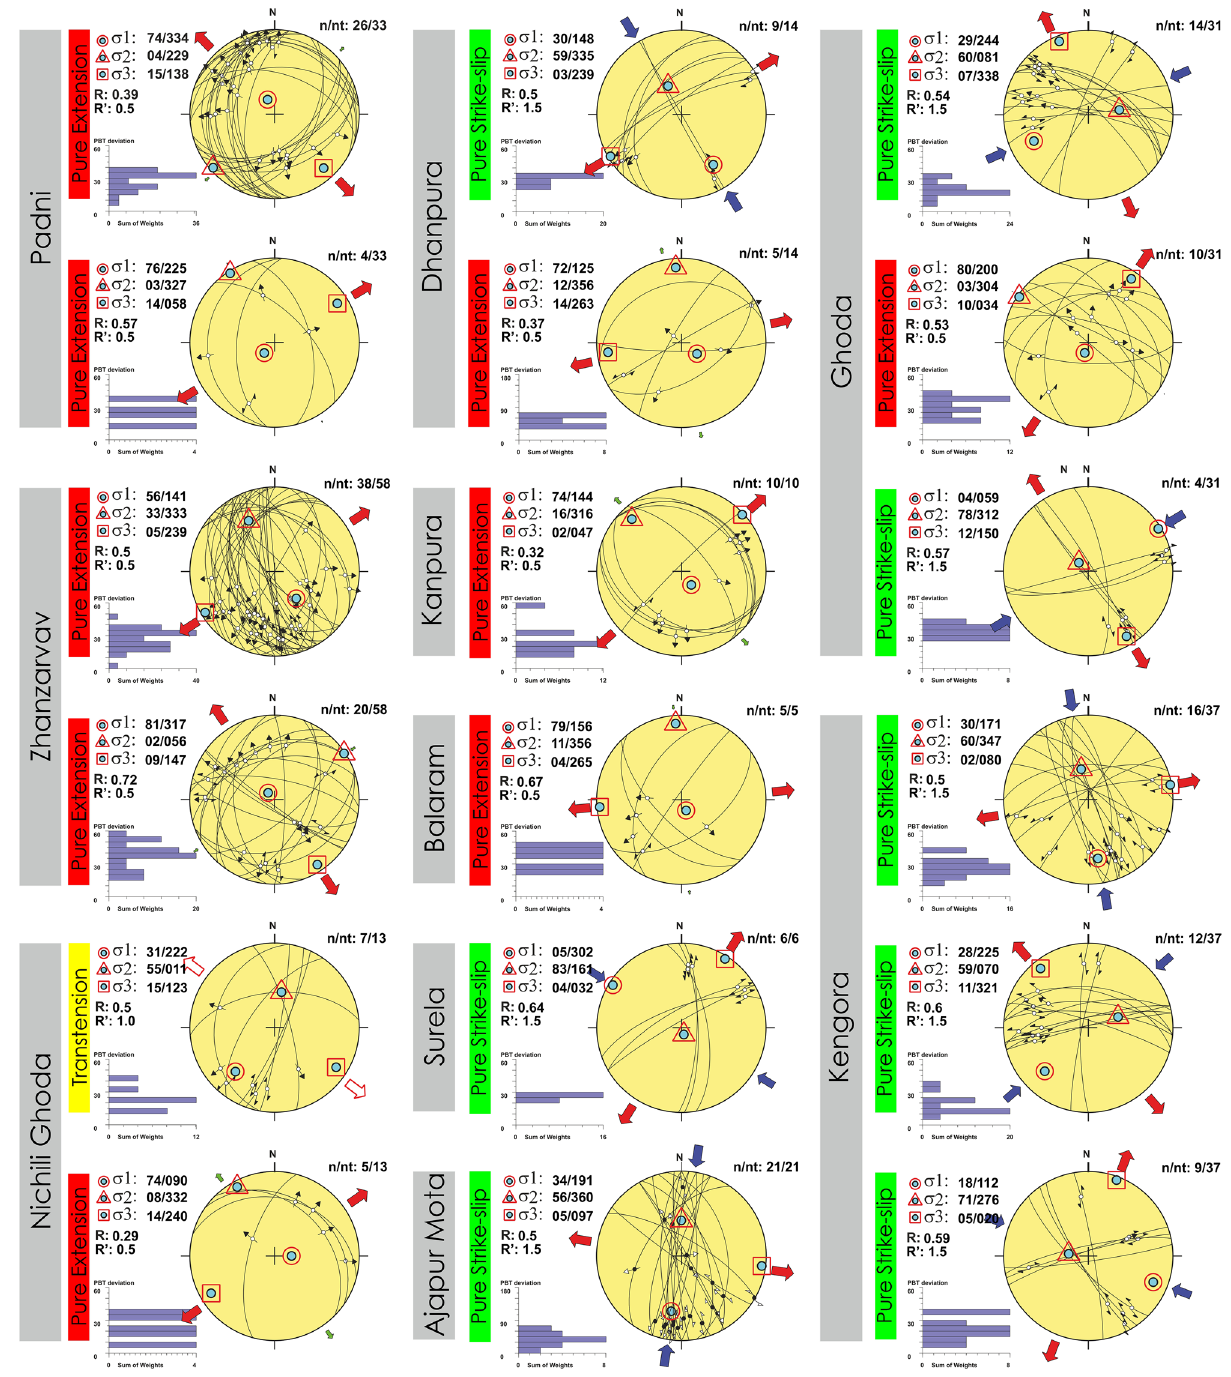
Figure 12. Paleostress analysis of fault-slip observations from different localities using the PBT method 48,49 . At different localities, the heterogeneous fault slip-observations were classified into different homogeneous subsets. n Number of data in a homogeneous subset. nt Total number of data measured. The histogram represents PBT deviations. Angular deviation approaches zero for best-fit data. R (Stress ratio) = (σ2 − σ3/σ1 − σ3). R ′ = Stress regime. Pure strike-slip and pure extension regimes predominate the